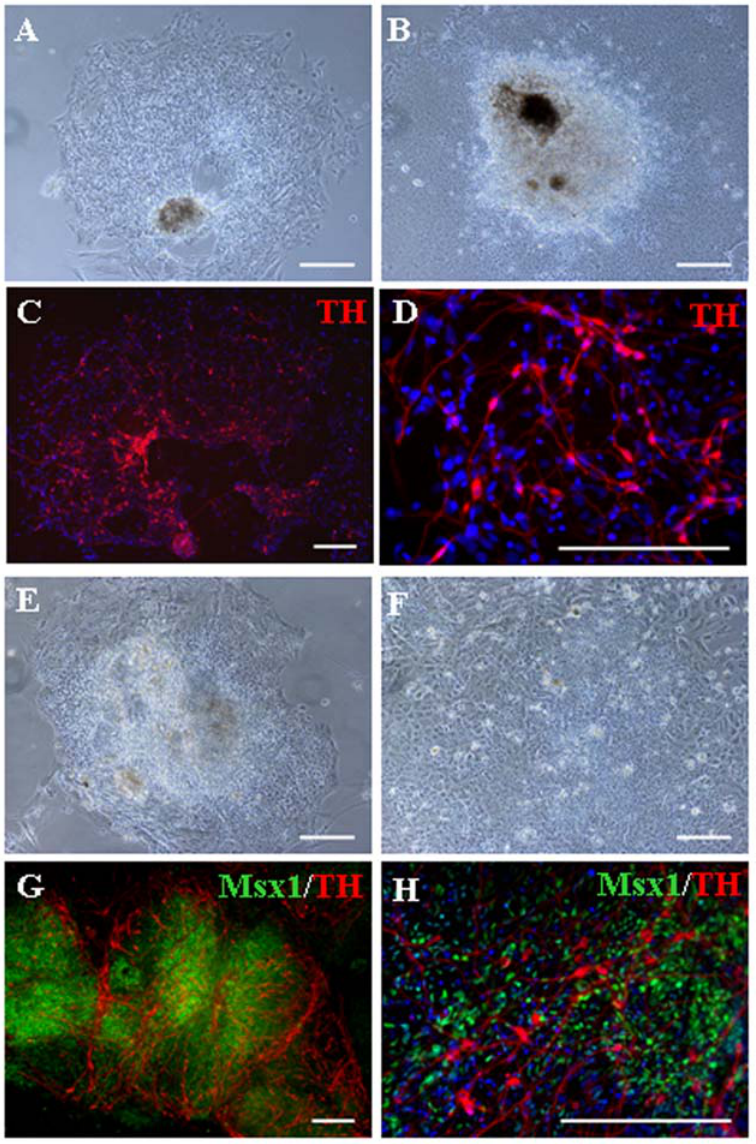
Figure 4. Effect of candidate molecules on differentiation of the BG02 and BG03 lines. Differentiation of EBs derived from the BG02 (A–D) and BG03 (E–H) hESC lines. Phase contrast images of (A) BG02-derived EBs differentiated in the presence of the candidate signaling molecules, SDF-1, IGF2, IGFBP4, PTN, EFNB1, or (B) in the absence of any factors, three days after seeding on adherent cultures. After 10 days of culture, TH- immunoreactive neurons were found in cultures treated with the five candidate molecules (C, D), and completely absent in the untreated cultures. Images of EBs generated from the BG03 cell line differentiating in the presence of candidate factors (E), or in cultures that did not contain any of the five molecules (F). (G, H) Expression of Msx1 and TH in BG03-derived cultures after 10 days of treatment with the selected factors, illustrating expression of Msx1 in the majority of cells within colonies. Scale bars=200 m m.